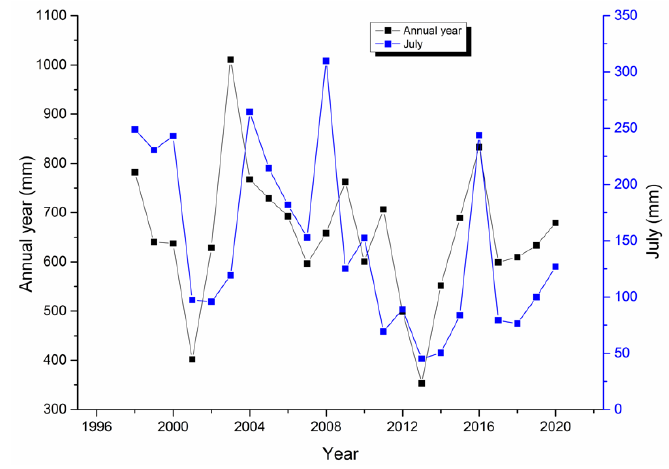
Figure 4. Rainfall in Zhengzhou.